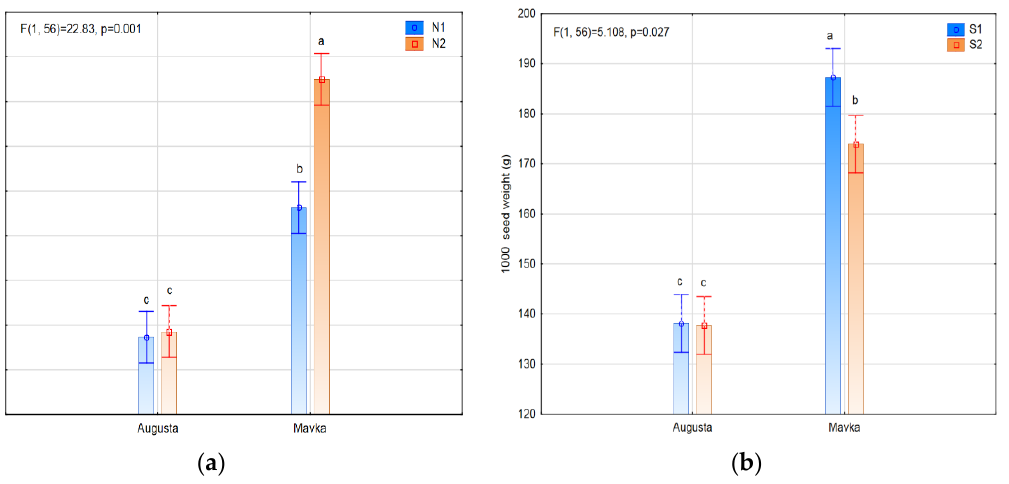
Figure 5. Significant interactions between fertilizer and cultivar ( A ) and sowing date and cultivar ( B ) on 1000 seed weight. The standard error (SD) of each mean is presented as an error bar. The occurrence of the same letter pointer at averages (at least one) means that there is no statistically significant difference between them.